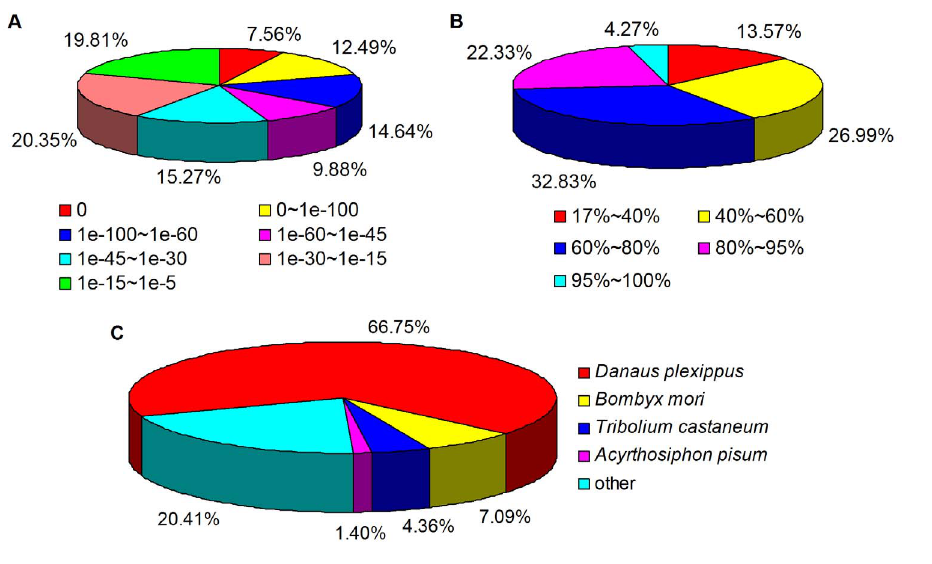
Figure 1. Characteristics of similarity search of unigenes against Nr databases. (A) E-value distribution of BLAST hits for each unigene with a cutoff E-value of 1E-5 in the Nr database. (B) Similarity distribution. (C) Species distribution. The distribution is shown as a percentage of the total BLAST hits for each unigene with a cutoff E-value of 1E-5 in the Nr database.